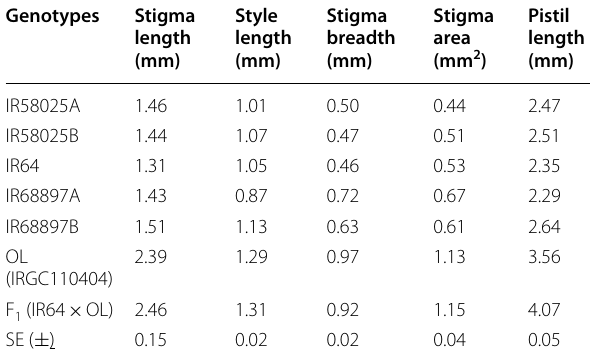
Table 1 Phenotypic characterization of parental lines and F (IR64 OL) for stigma traits ×